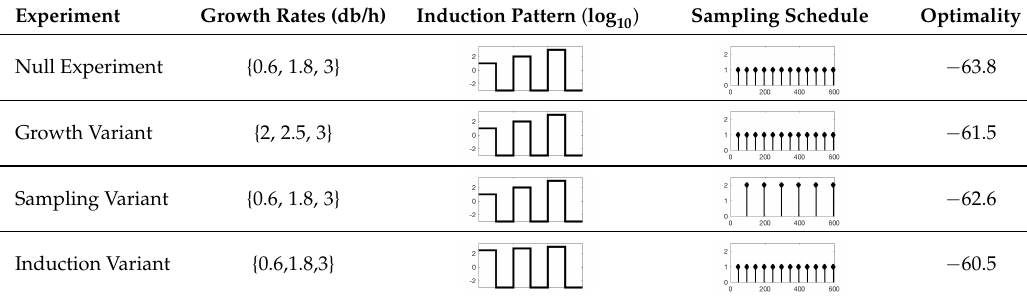
Table 2. Null (non-optimal) experimental